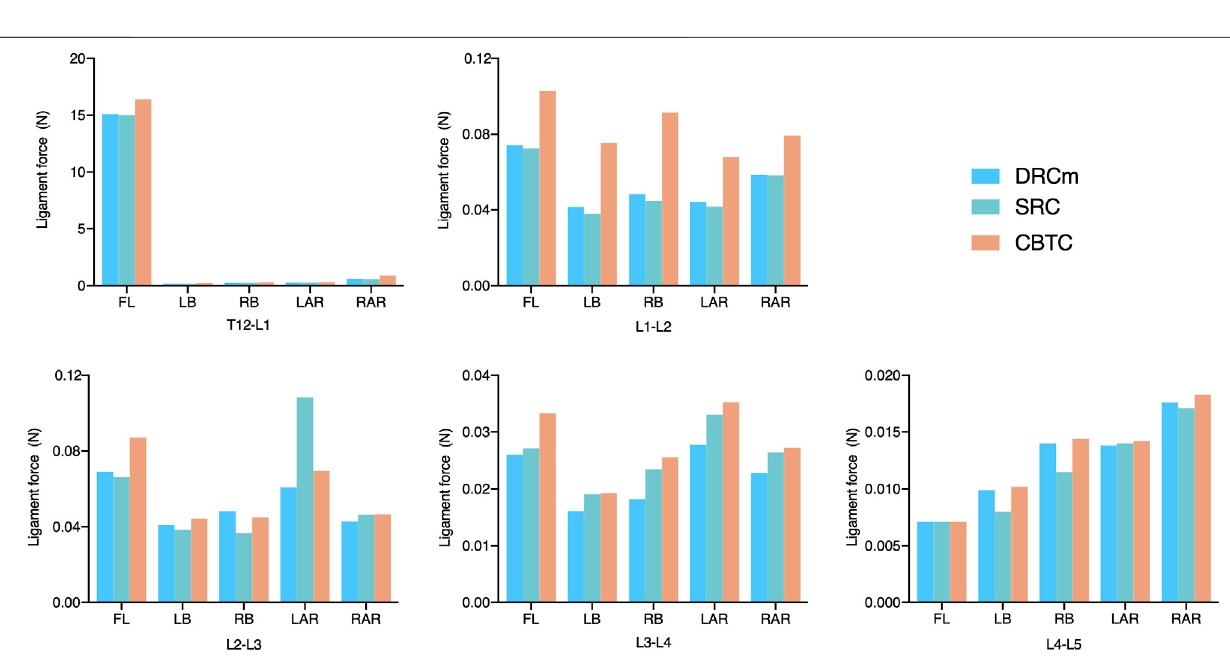
Frontiers in Bioengineering and Biotechnology |